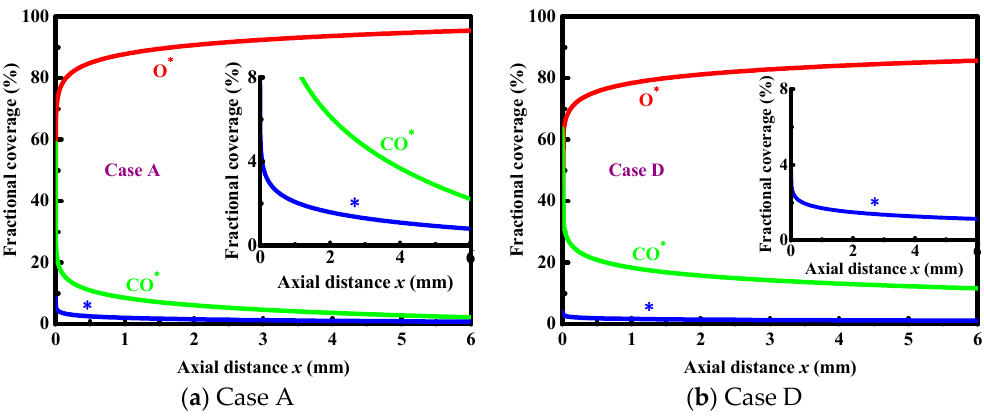
Figure 9. Fractional coverage of empty sites and major species for Cases A and D, obtained from the improved mechanism herein.